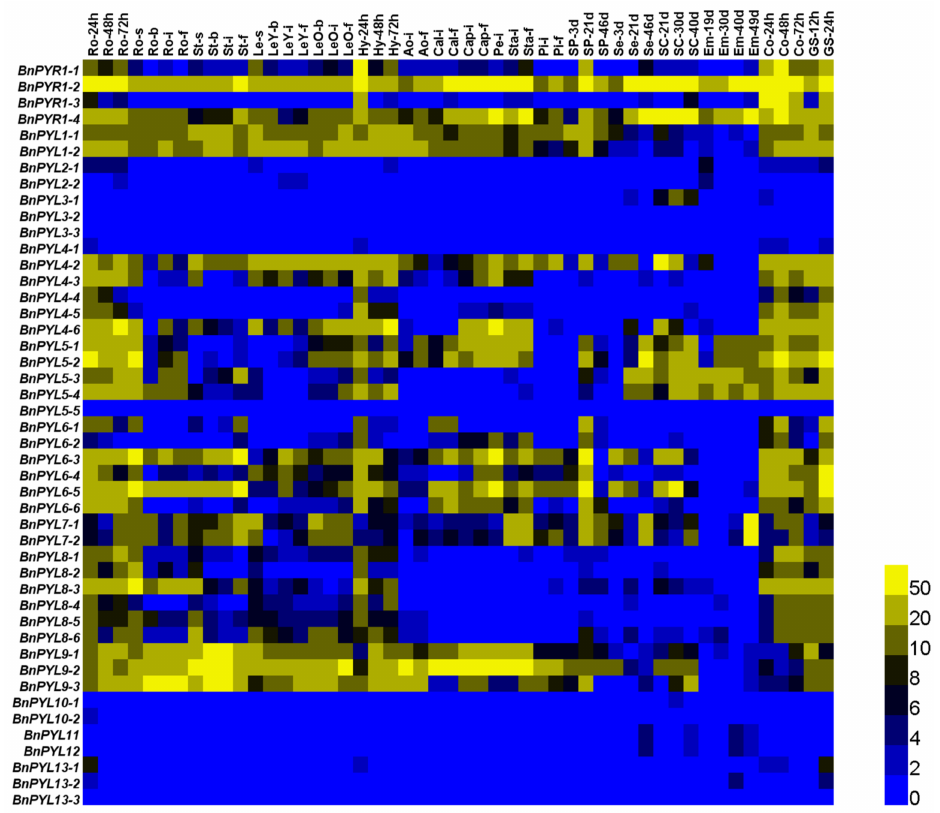
Figure 6. Expression levels of BnPYL genes in different tissues and at different stages of B. napus. Ro, root; St, stem; Le, leaf; Hy, hypocotyl; Ao, anthocaulus; Cal, calyx; Cap, capillament; Pe, petal; Sta, stamen; Pi, pistil; SP, silique; Se, seed; SC, seed coat; Em, embryo; Co., cotyledon; GS, germinate seed. s, seedling stage; b, bud stage; i, initial flowering stage; and, f, full-bloom stage. The 24, 48, and 72 h labels indicate the time that had passed after seed germination. The 3, 19, 21, 30, 40, and 46 d labels indicate the number of days that had passed after the flowering stage. The bar on the lower right corner represents fragments per kilobase of exon per million reads mapped (FPKM) values, and different colors represent different expression